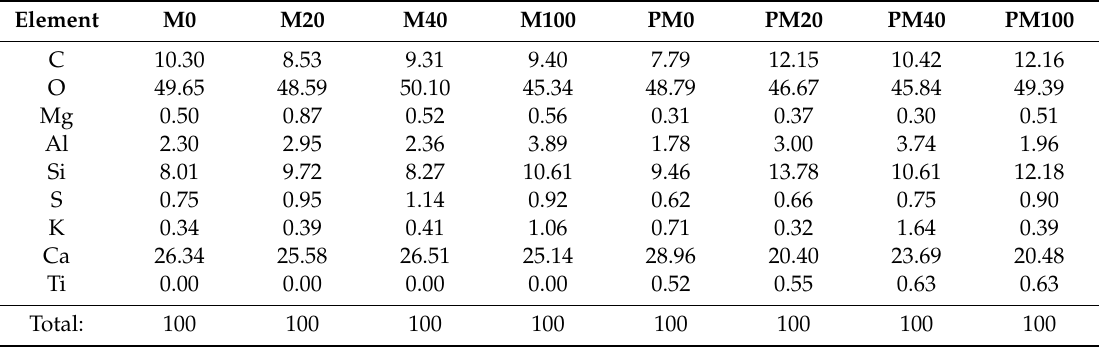
Table 5. Average percentage, by weight, of elements by scanning electron microscopy